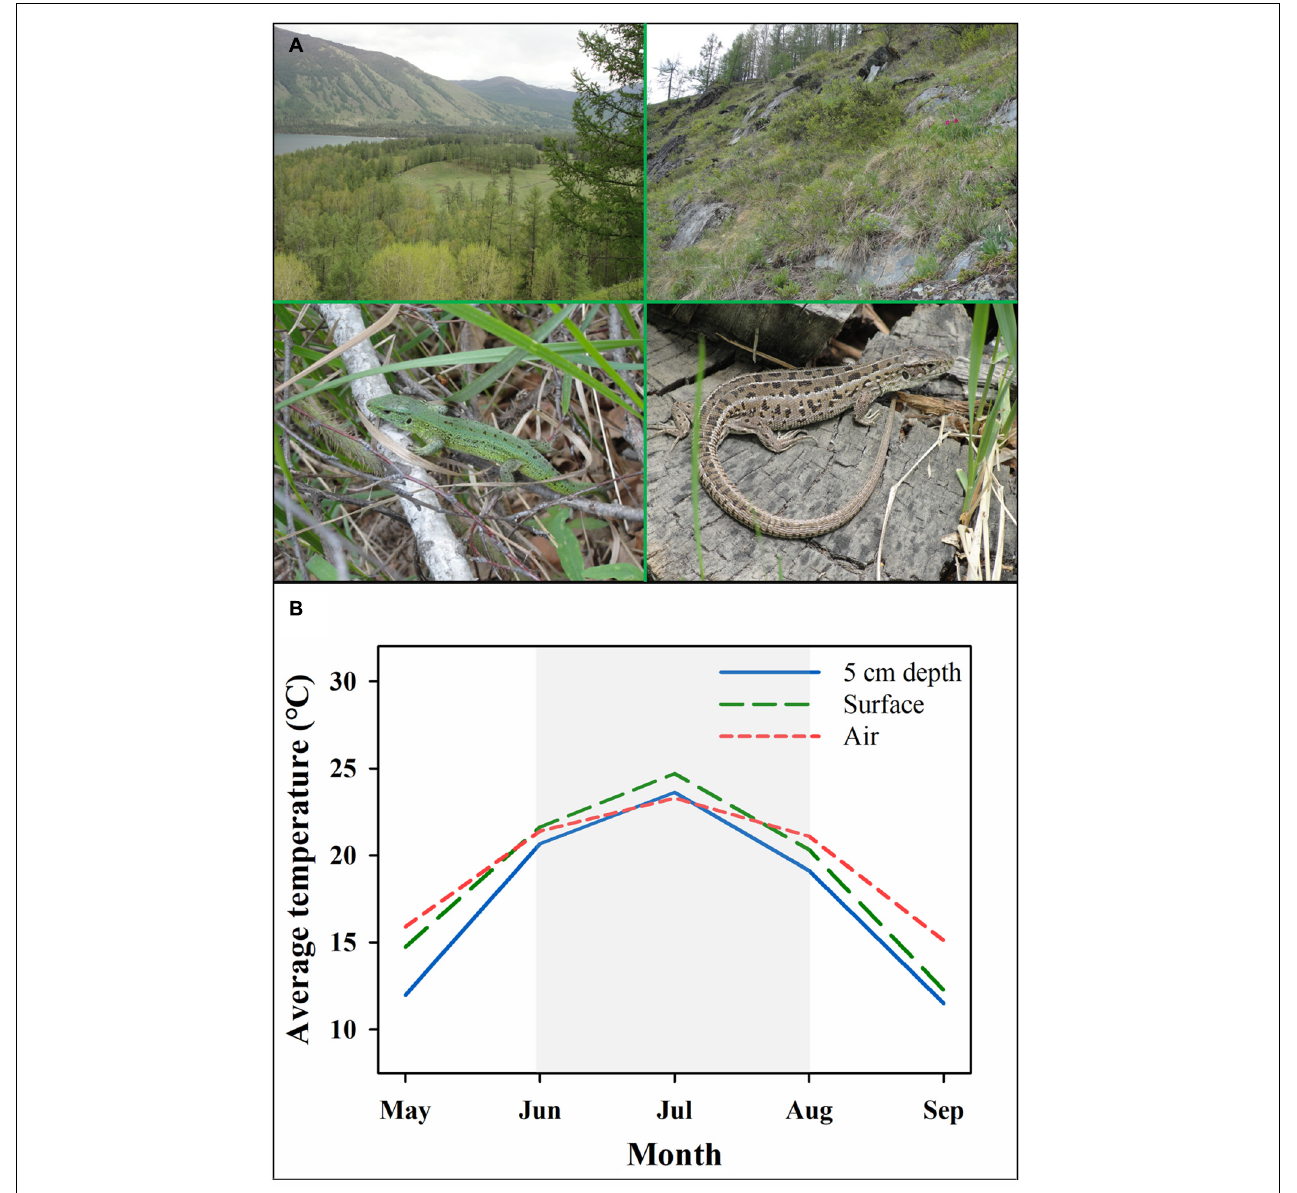
FIGURE 1 | Natural habitats of (A) and thermal environments (B) for sand lizards ( Lacerta agilis ) from Burqin population. (A) The photographs indicate the natural habitats and demographic photographs for Lacerta agilis . (B) The blue solid, green long dash and red short dash lines indicate the temperatures of nest at depth of 5 cm underground, surface and air. The shade column indicates the reproductive season mainly for embryonic development. The data of temperatures were from China Meteorological Data Service Centre